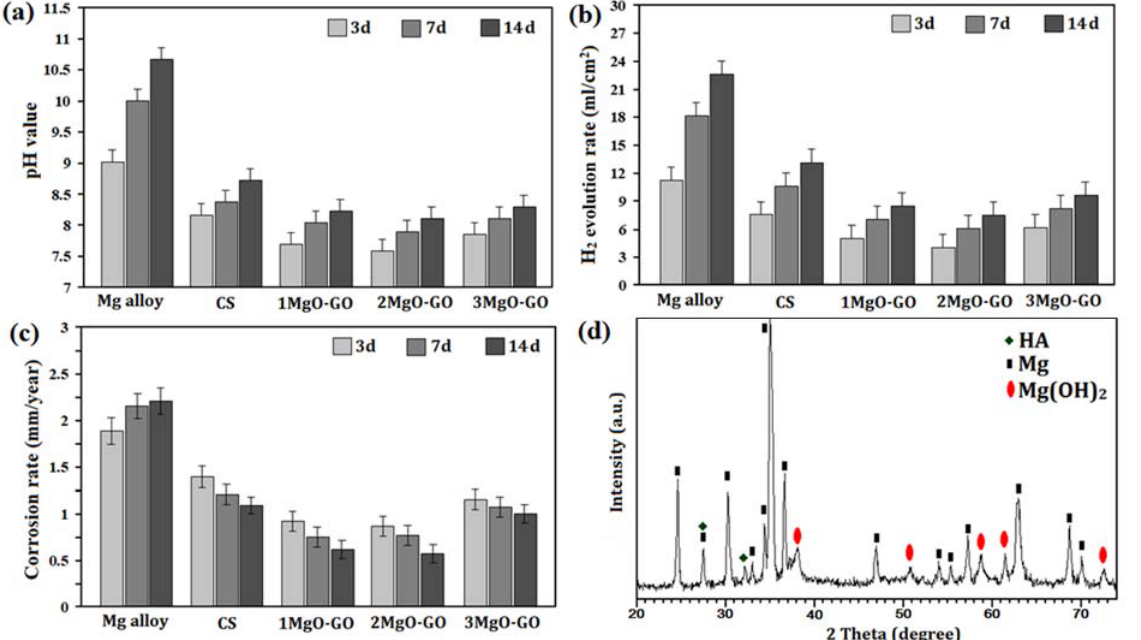
Figure 9. ( a ) pH value, ( b ) hydrogen evolution, ( c ) corrosion rate for uncoated Mg alloy, CS, CS/1MgO ‐ GO, CS/2MgO ‐ GO, and CS/3MgO ‐ GO coated Mg samples coated Mg alloys versus soaking time in SBF. ( d ) X ‐ ray diffraction patterns of CS/3MgO ‐ GO coated Mg alloy after soaking in SBF.